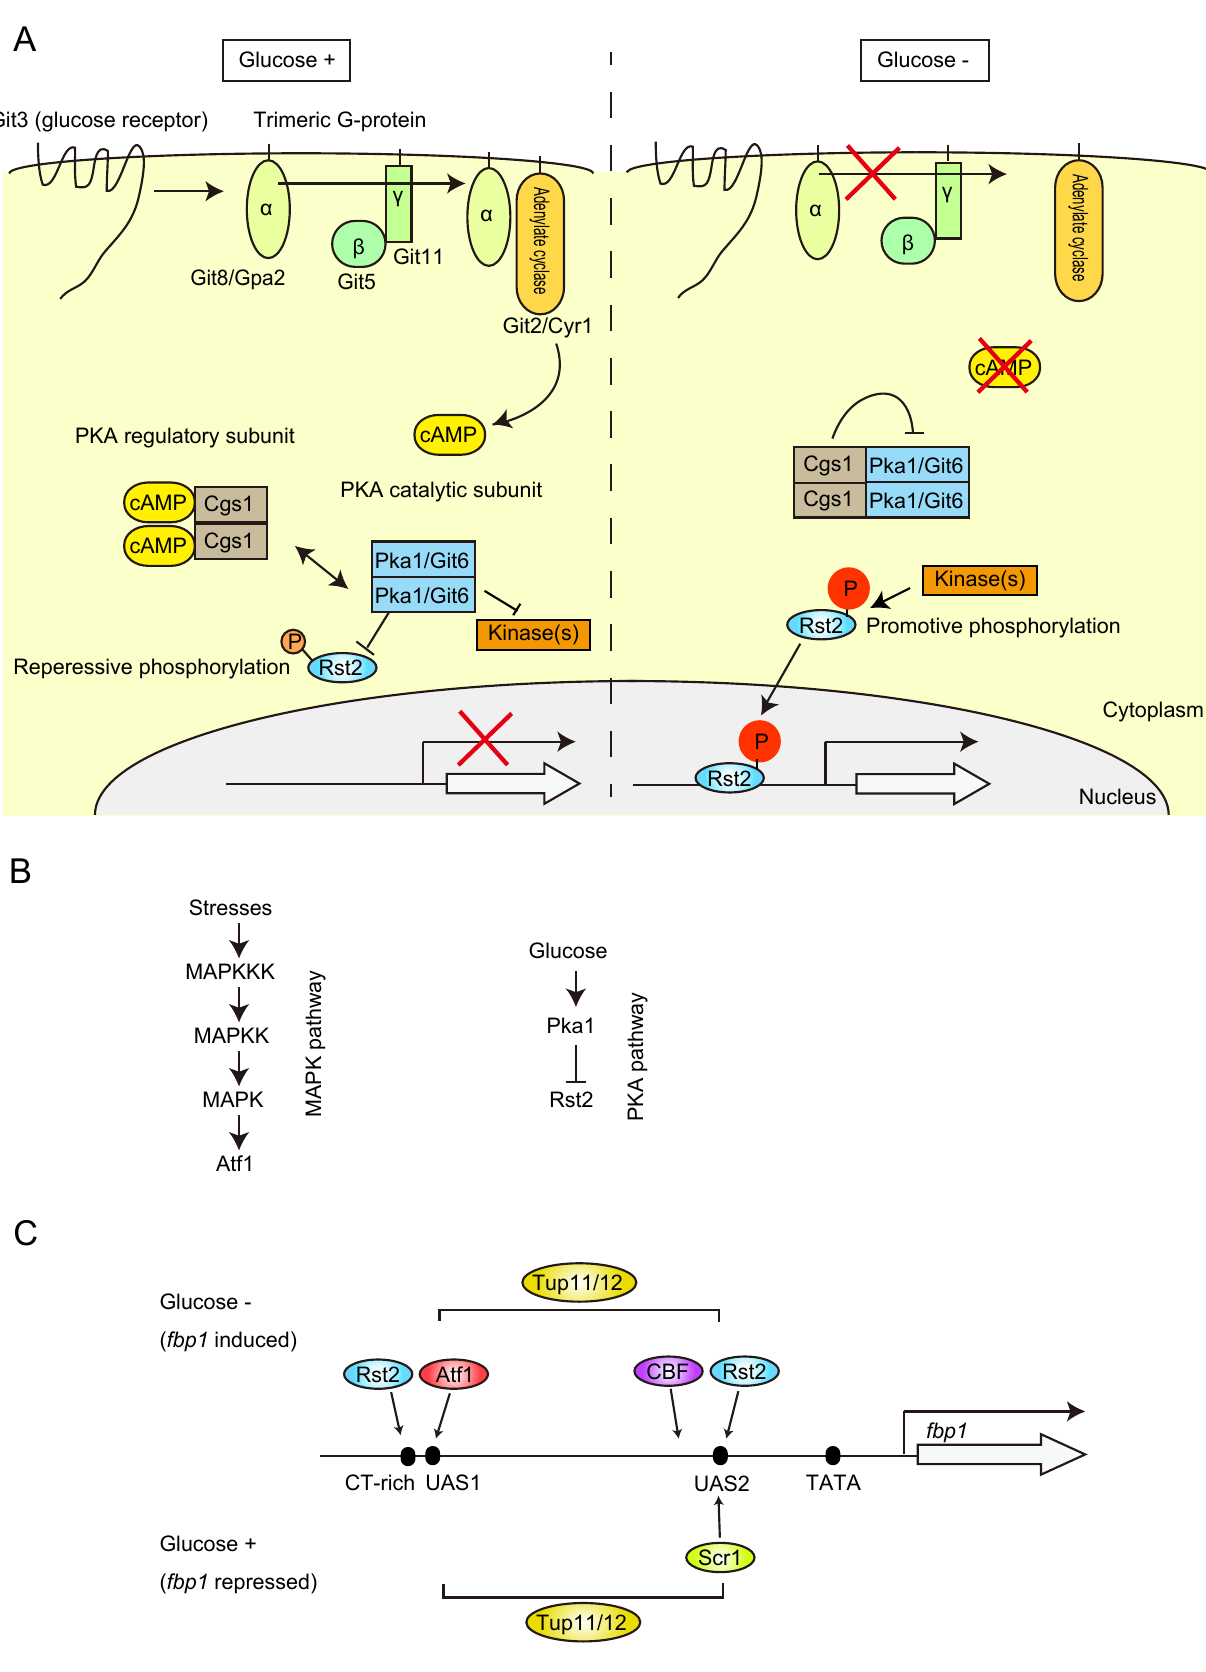
Figure 1. Signal pathways and TFs involved in the regulation of fbp1 gene. ( A ) Schematic